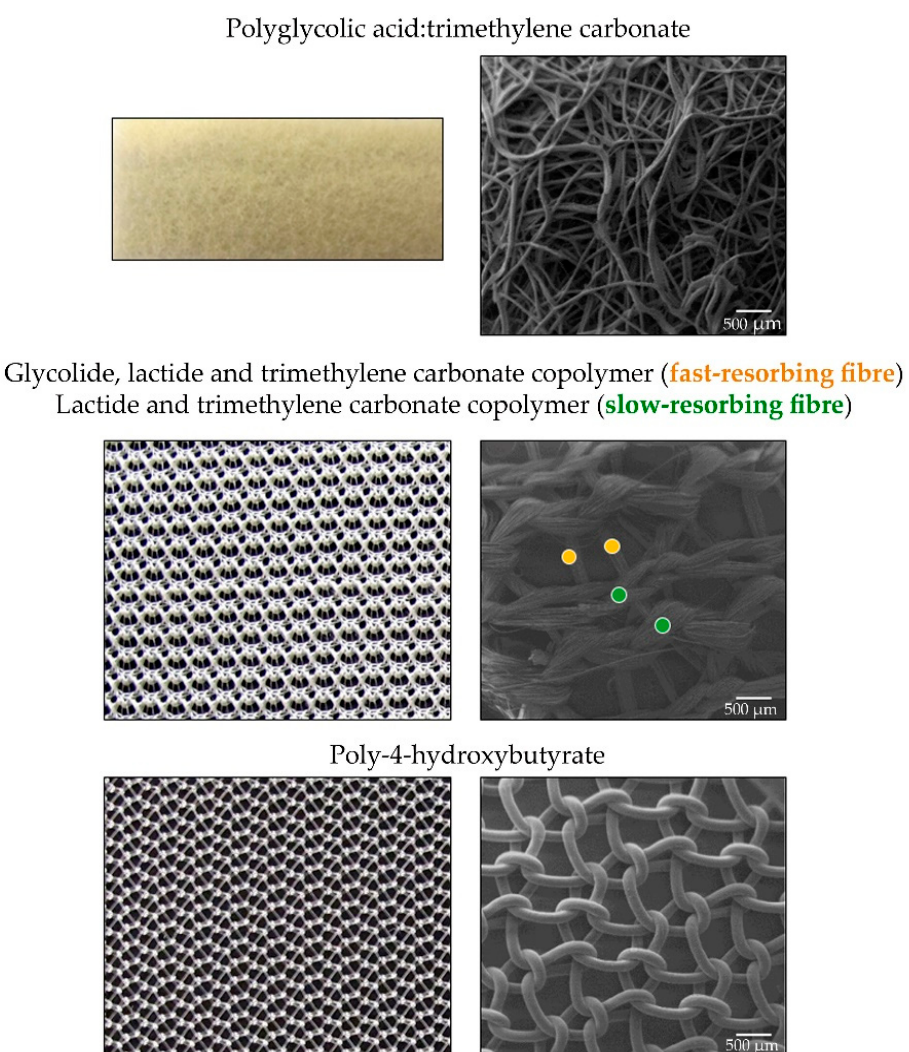
Figure 8. Research in new synthetic meshes are giving rise to fully absorbable products, like bio- compatible synthetic polymers that are gradually absorbed by the host (macroscopic -left- and scanning electron microscopy images-right,50×). Scale bar: 500 μ m.